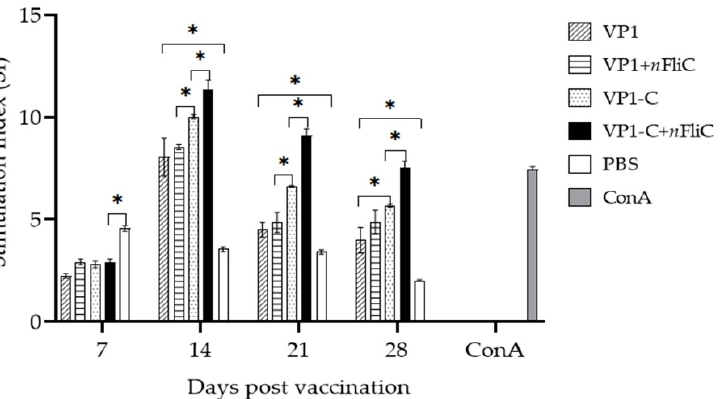
Figure 3. T cell proliferation of PBMCs from vaccinated ducklings. Ducklings ( n = 3 per group) were vaccinated once with five different vaccine formulations: (1) VP1, (2) VP1 + n FliC, (3) VP1-C, (4) VP1-C + n FliC, and (5) PBS. Isolated PBMCs were stimulated with VP1, and proliferation extent was measured using the MTT assay. ConA was used as the positive control. Data are presented as mean ± SD. An asterisk indicates statistically significant difference ( p < 0.05).